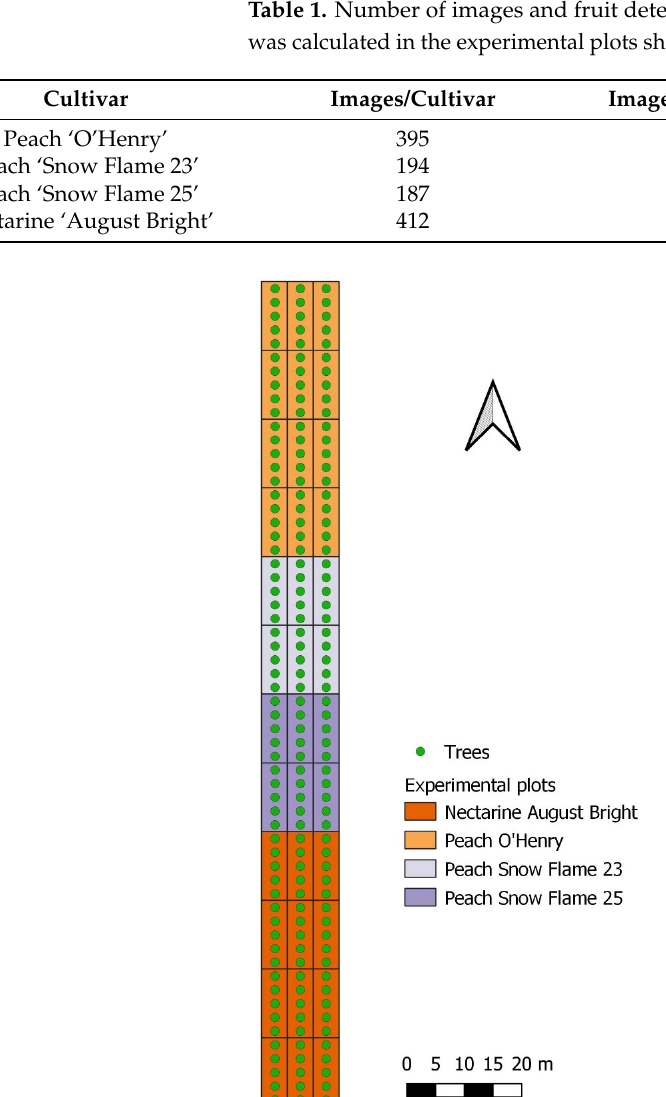
Table 1. Number of images and fruit detections from which the Colour Development Index (CDI)